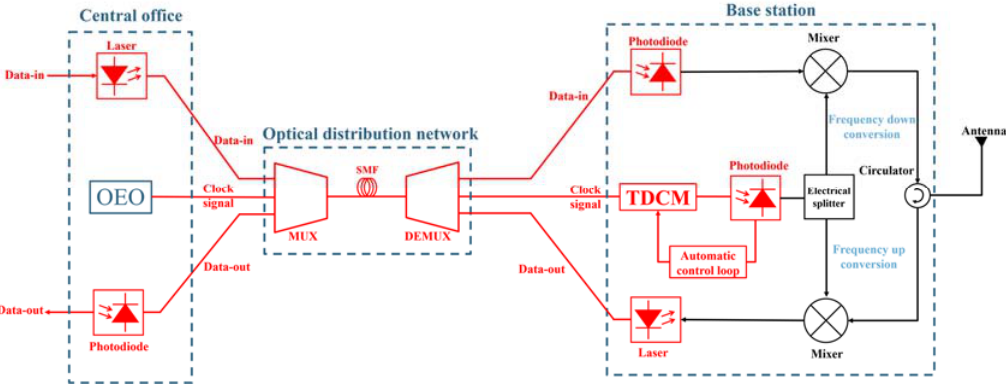
Figure 10. Use of an OEO as a local oscillator (LO) for a 5G radio access network (RAN) fronthaul. Reprinted from Reference [93].